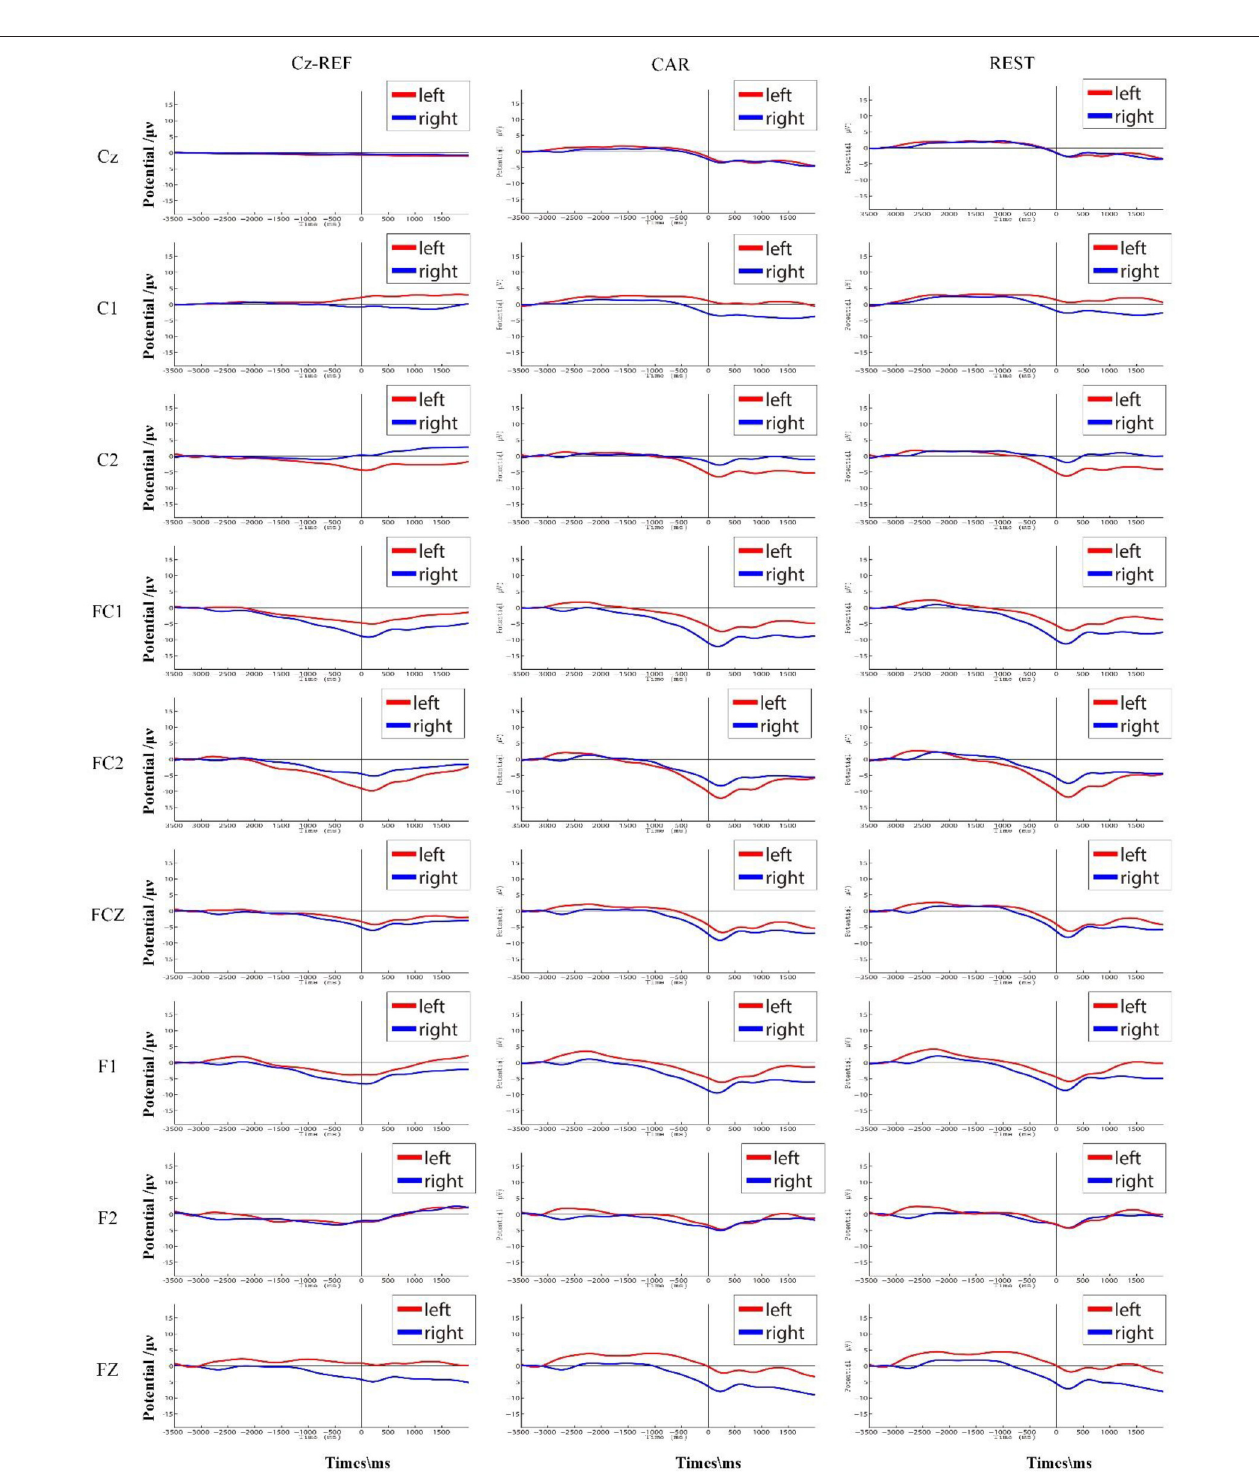
FIGURE 5 | S7’s average RP interval (corresponding to [ − 3.5s, 2s] with respect to muscle movement) in three references. The RPs of the left and right hand movements are shown in red and blue, respectively.